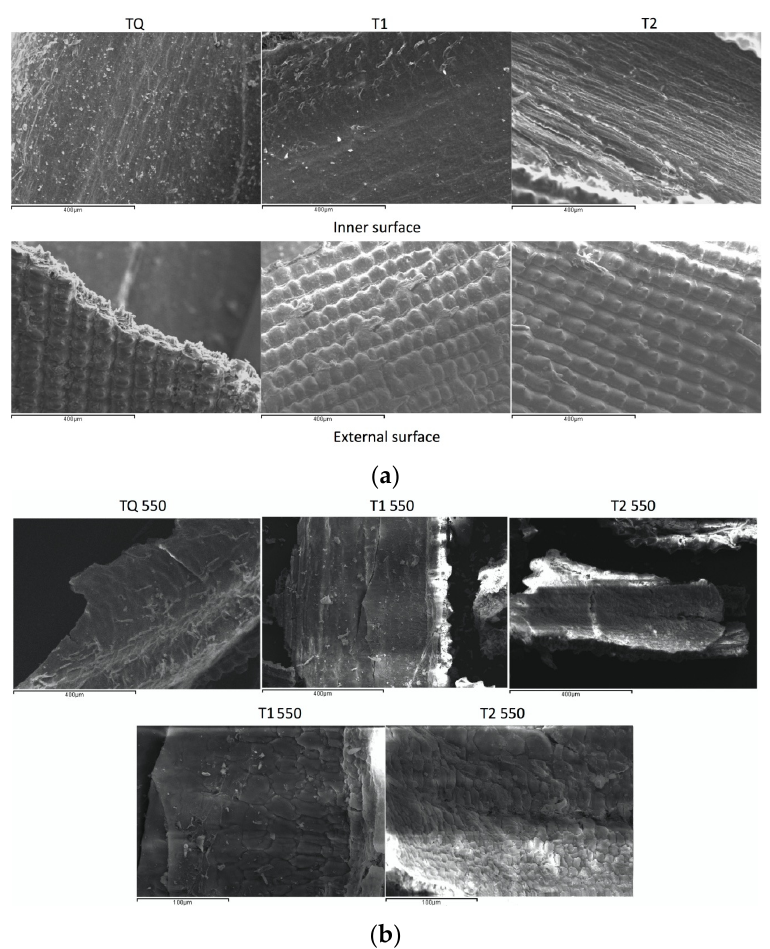
Figure 4. ( a ) SEM images of internal and external surfaces of untreated rice husk (TQ) and pre-treated by T1 and T2 DIC treatments. ( b ) SEM images of internal surfaces of corresponding RHA shown in Figure 4a.